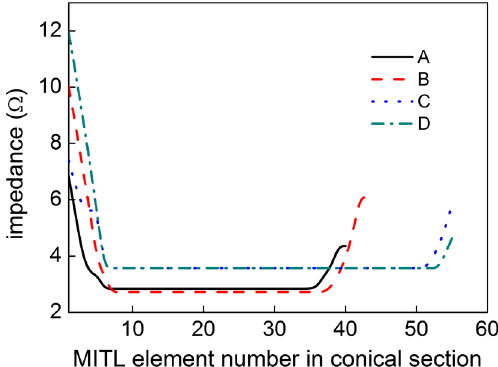
FIG. 8. Current loss in four MITL levels as a function of time. Current loss in the B (red dash) and D (dash dotted dark cyan) levels are higher than in the A (black solid) and C (blue dotted) levels, and last much longer in time. The difference in level voltage is the main reason for this, although impedance is another factor that takes current to a critical value.